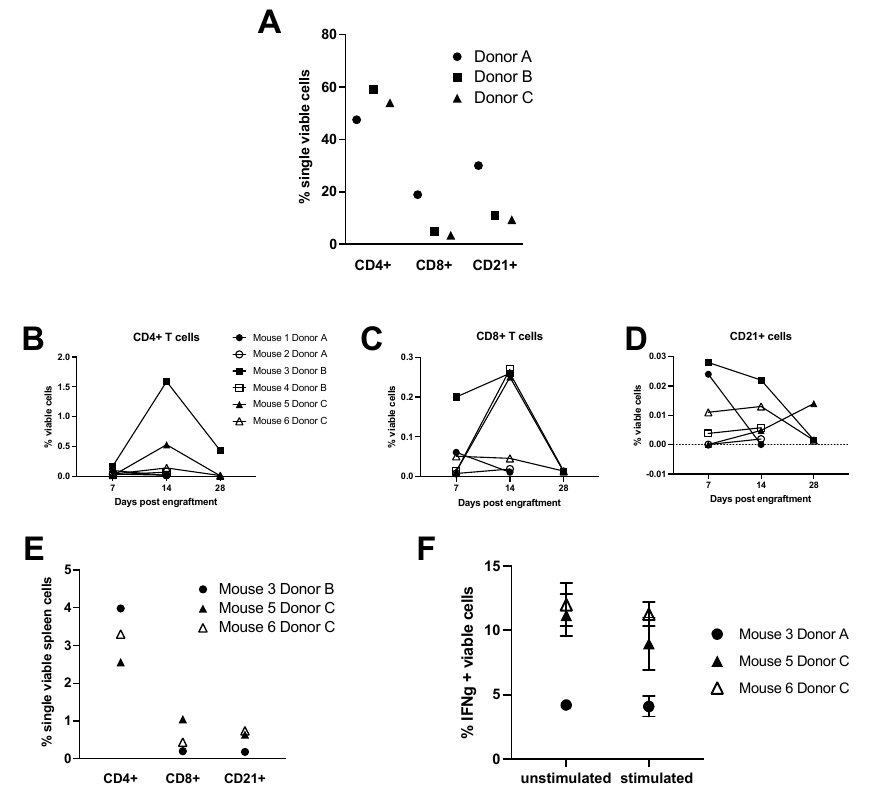
Figure 3. Equine PBL transfer into NSG hosts. ( A ) Donor horse peripheral blood lymphocyte populations post-gradient centrifugation separation and prior to engraftment. ( B – D ) Percentages of equine CD4+, CD8+, CD21+ lymphocyte populations, respectively, in the peripheral blood of mouse recipients at day 7, 14, and 28 post-engraftment. ( E ) Percentages of equine CD4+, CD8+, CD21+ lymphocyte populations in the spleens of mouse recipients at 28 days post-engraftment. Splenic cells from the remaining 3 mouse hosts were cultured for 12 hours in the presence of PMA and ionomycin. Interferon gamma positive cells were assessed and compared with unstimulated cells ( F ).